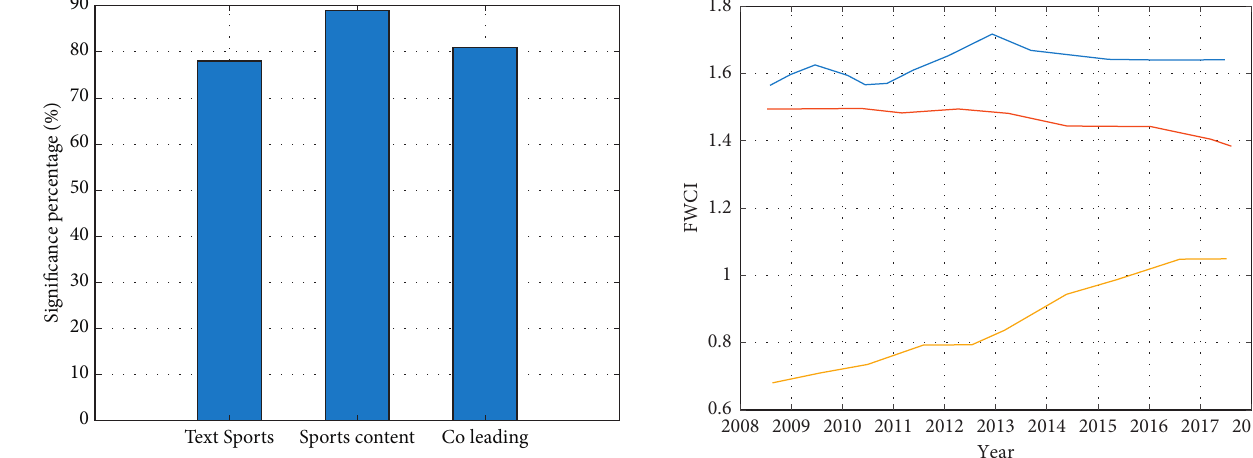
Figure 11: Percentage significance of each dominant type of re- search topic cluster in the whole domain.